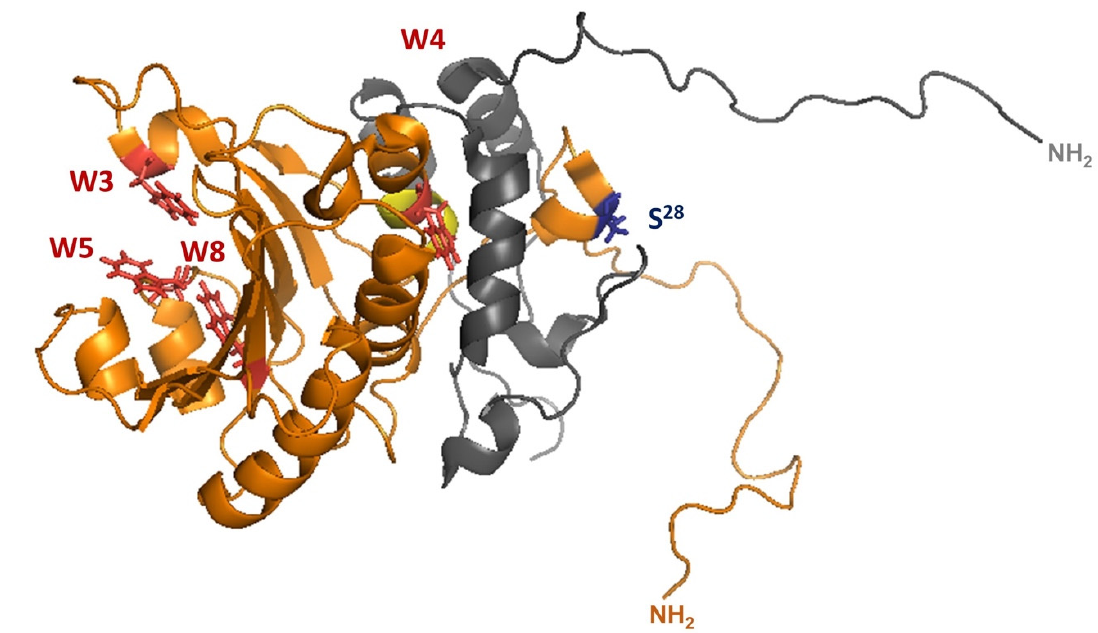
Figure 1. 3D structure (1RF8) of S. cerevisiae eIF4E (gold) in complex with eIF4G (grey; aa 393 to 490). Displayed in red are aromatic residues W3, W5 and W8 in the cap-binding groove and aromatic residue W4 located at the dorsal part of eIF4E which interacts with eIF4G. Highlighted in yellow is the conserved S/TVxxF motif forming helix1 next to W4. Phosphorylated residue S28 of S. cerevisiae eIF4E is displayed in blue.